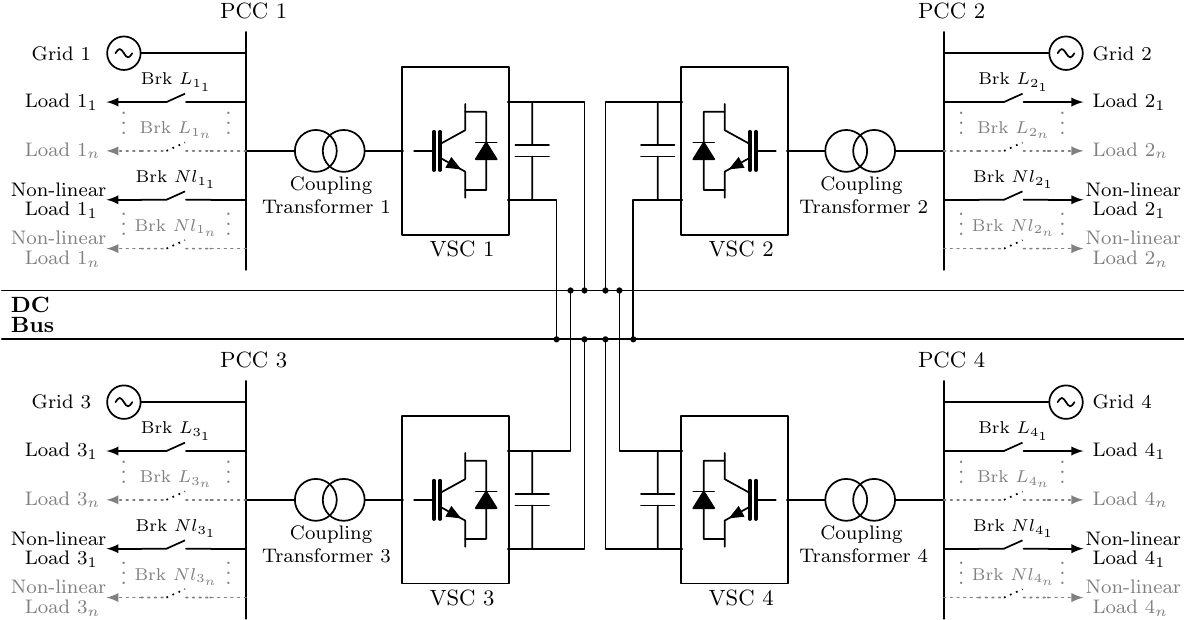
Figure 1. Scheme of a four-terminal high-voltage direct current (HVDC) system. VSC—voltage-source